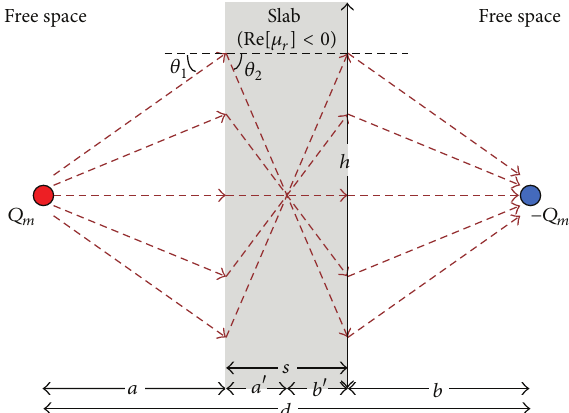
Figure2:Effectsofmagneticfluxfocusingusingtwomagneticpoint charges and a metamaterial